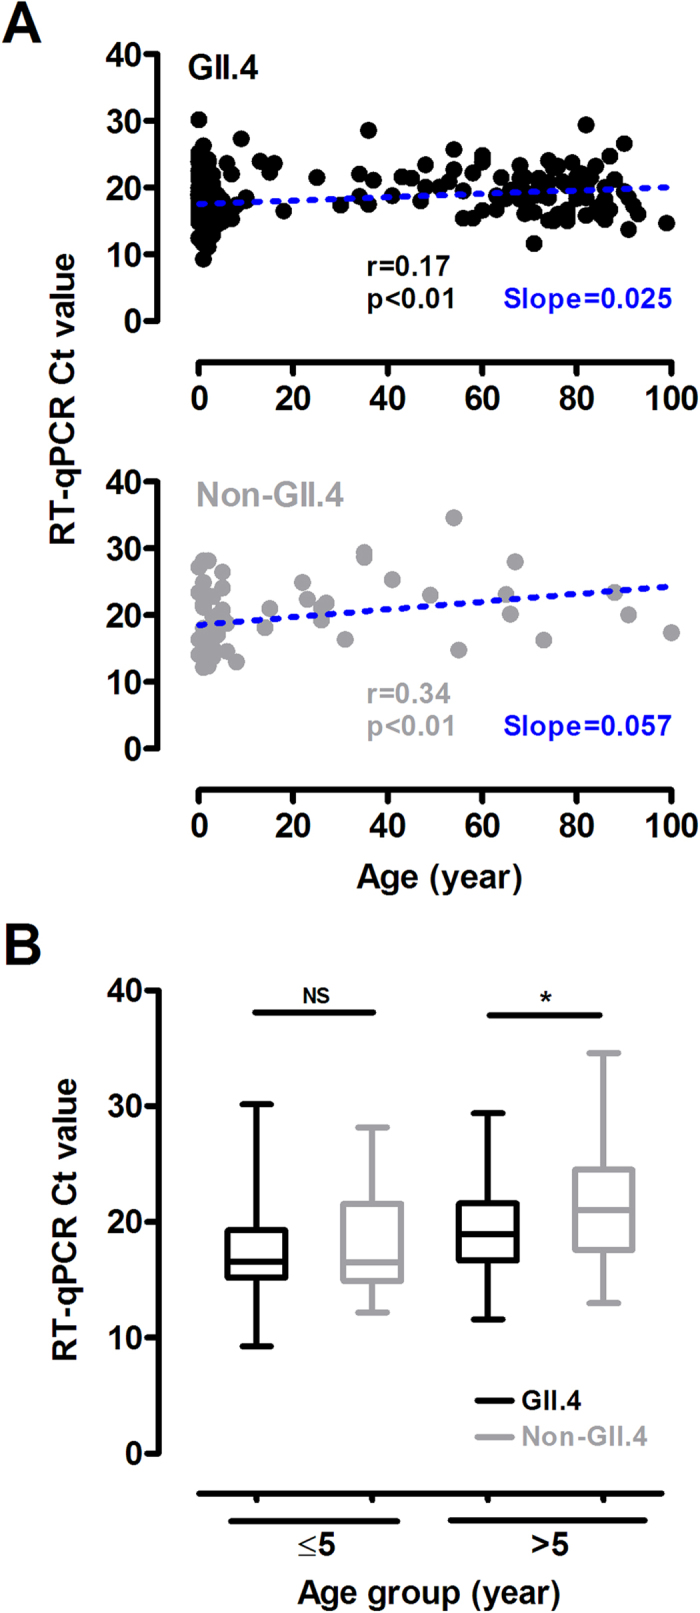
Fecal viral load of norovirus genogroup II genotype 4 (GII.4) and non-GII.4 gastroenteritis on case presentation by(A) age and (B) age group. Cycle threshold (Ct) value of reverse transcription–polymerase chain reaction (RT-qPCR) assay was determined for each case to represent noroviral load. Higher Ct values indicate lower noroviral loads. Blue dotted lines indicate best-fit lines. In panel B, for clarity only p-values (Mann-Whitney U test) of comparisons between GII.4 and non-GII.4 cases were shown. Other comparisons were described in the main text where appropriate. Red horizontal lines denote medians. NS, not significant; r, Spearman’s rank correlation coefficient; *, p < 0.05.